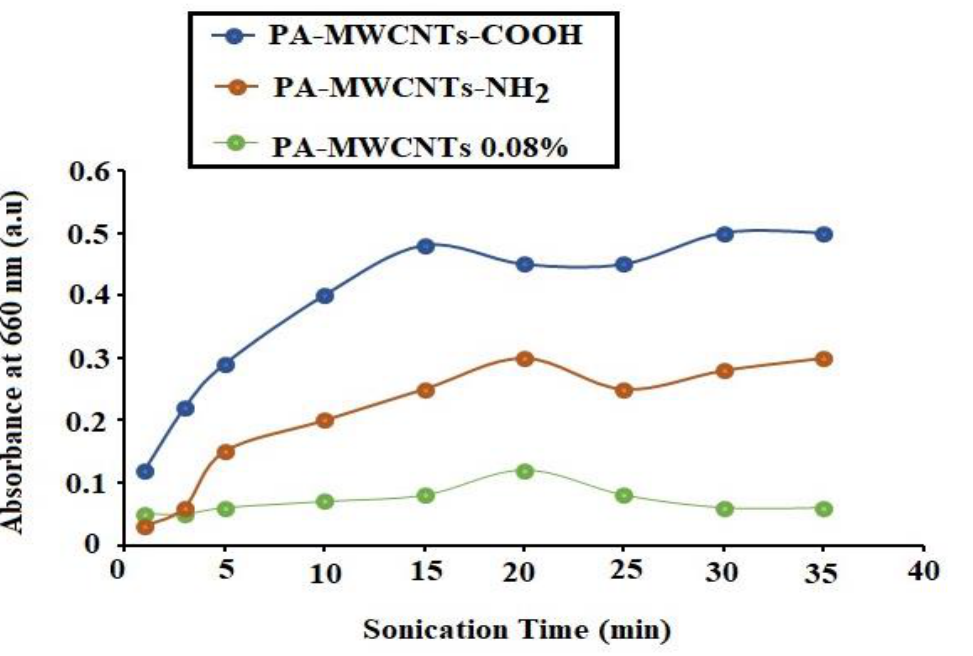
Figure 2. Sonication time of PA-MCWNTs, PA-MWCNTs − COOH, and PA-MWCNTs-NH 2